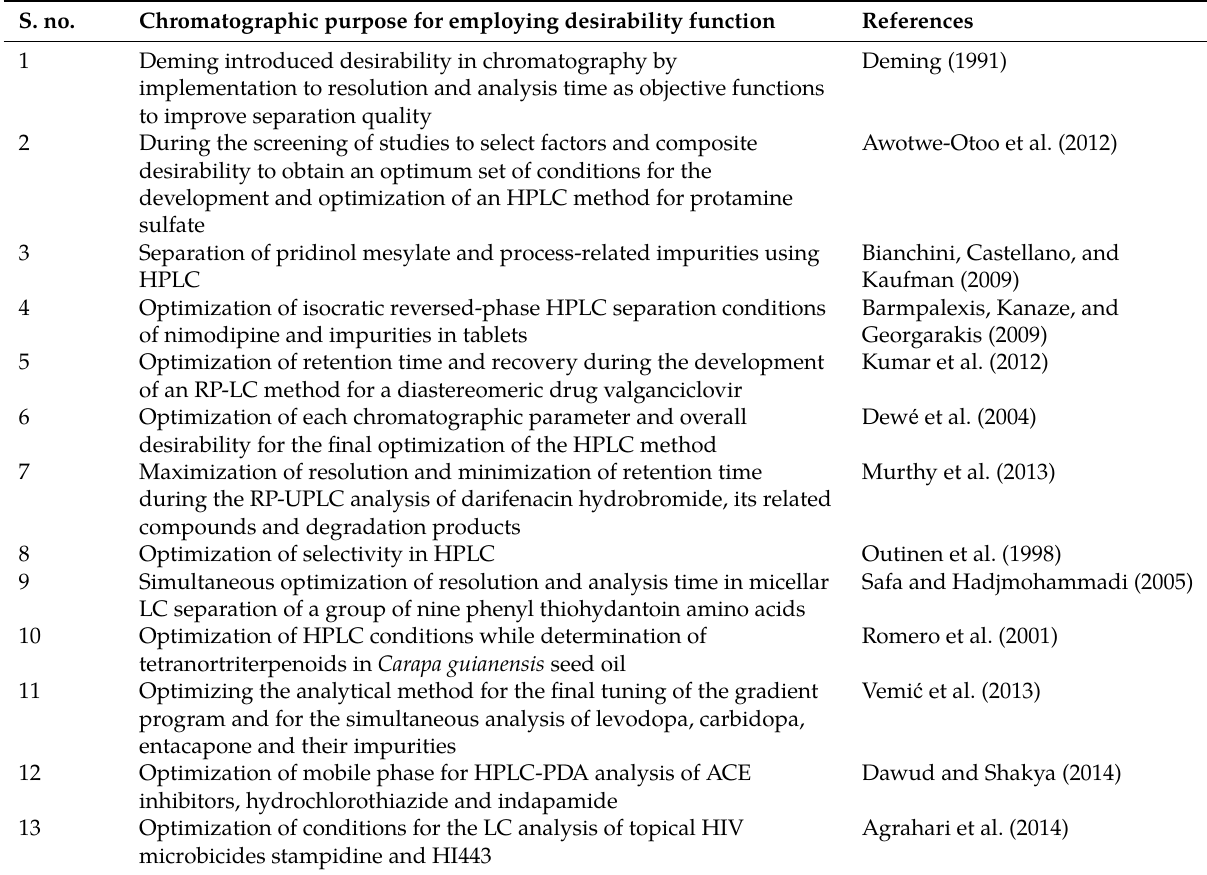
Table 2: Characteristic chromatographic applications of desirability function. S.